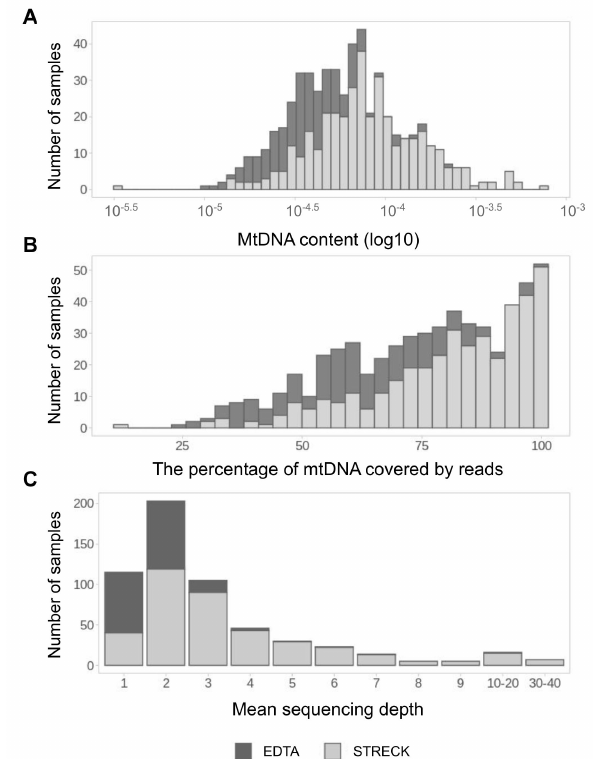
Figure 1. The quantitative analysis of the mtDNA pool in samples. MtDNA content ( A ), mtDNA coverage ( B ) and sequencing depth ( C ) distribution in samples collected to EDTA (dark-grey) and Streck (light-grey) sample